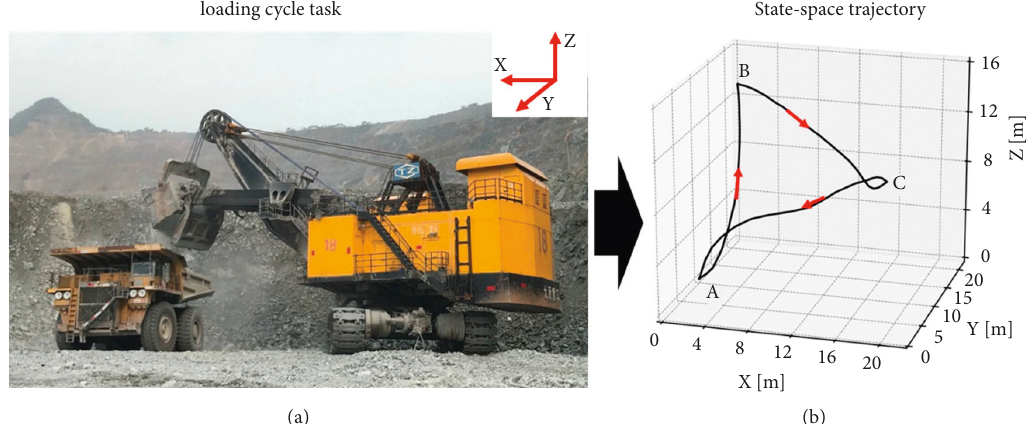
Figure 2: (a) Example of a cable shovel performing loading task; (b) diagram of a three-dimensional trajectory of a bucket moving in the loading cycle. X is the straight-line direction of the bucket rod when unloading; Y is the direction of the vertical excavation surface of the blasting pile; and Z is the direction perpendicular to the